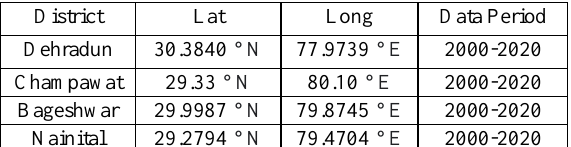
Figure 1. Study Area